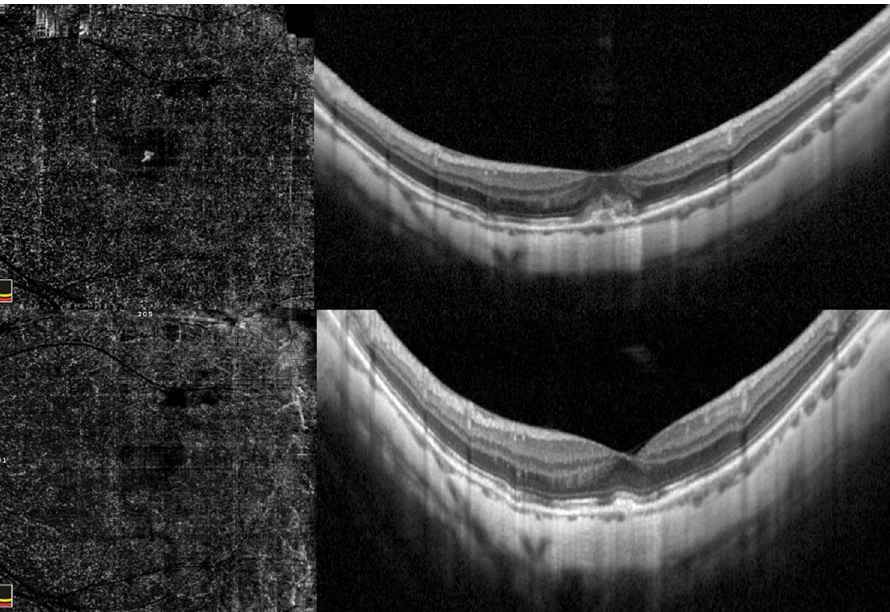
Figure 1. Immature myopic CNV. Baseline OCTA examination of a case of immature subfoveal myopic CNV (top left). The corresponding SD-OCT image shows the hyperreflective subretinal exudation with fuzzy borders, absence of intraretinal cysts and subretinal fluid (top right). OCTA at the final visit (12 months) after two intravitreal injections highlight the complete regression of the neovascular network (bottom left) and SD-OCT scan shows the disappearance of the subretinal material (bottom right).